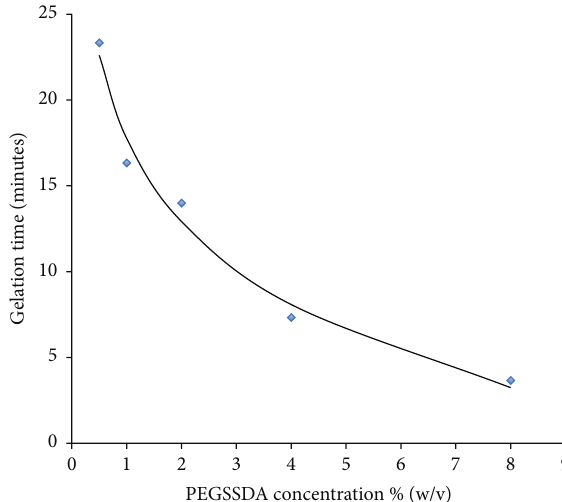
Figure 1: Gelation time as a function of PEGSSDA concentration fit to a nonlinear logarithmic regression model. Diamonds represent experimental data. The curved line is theoretical